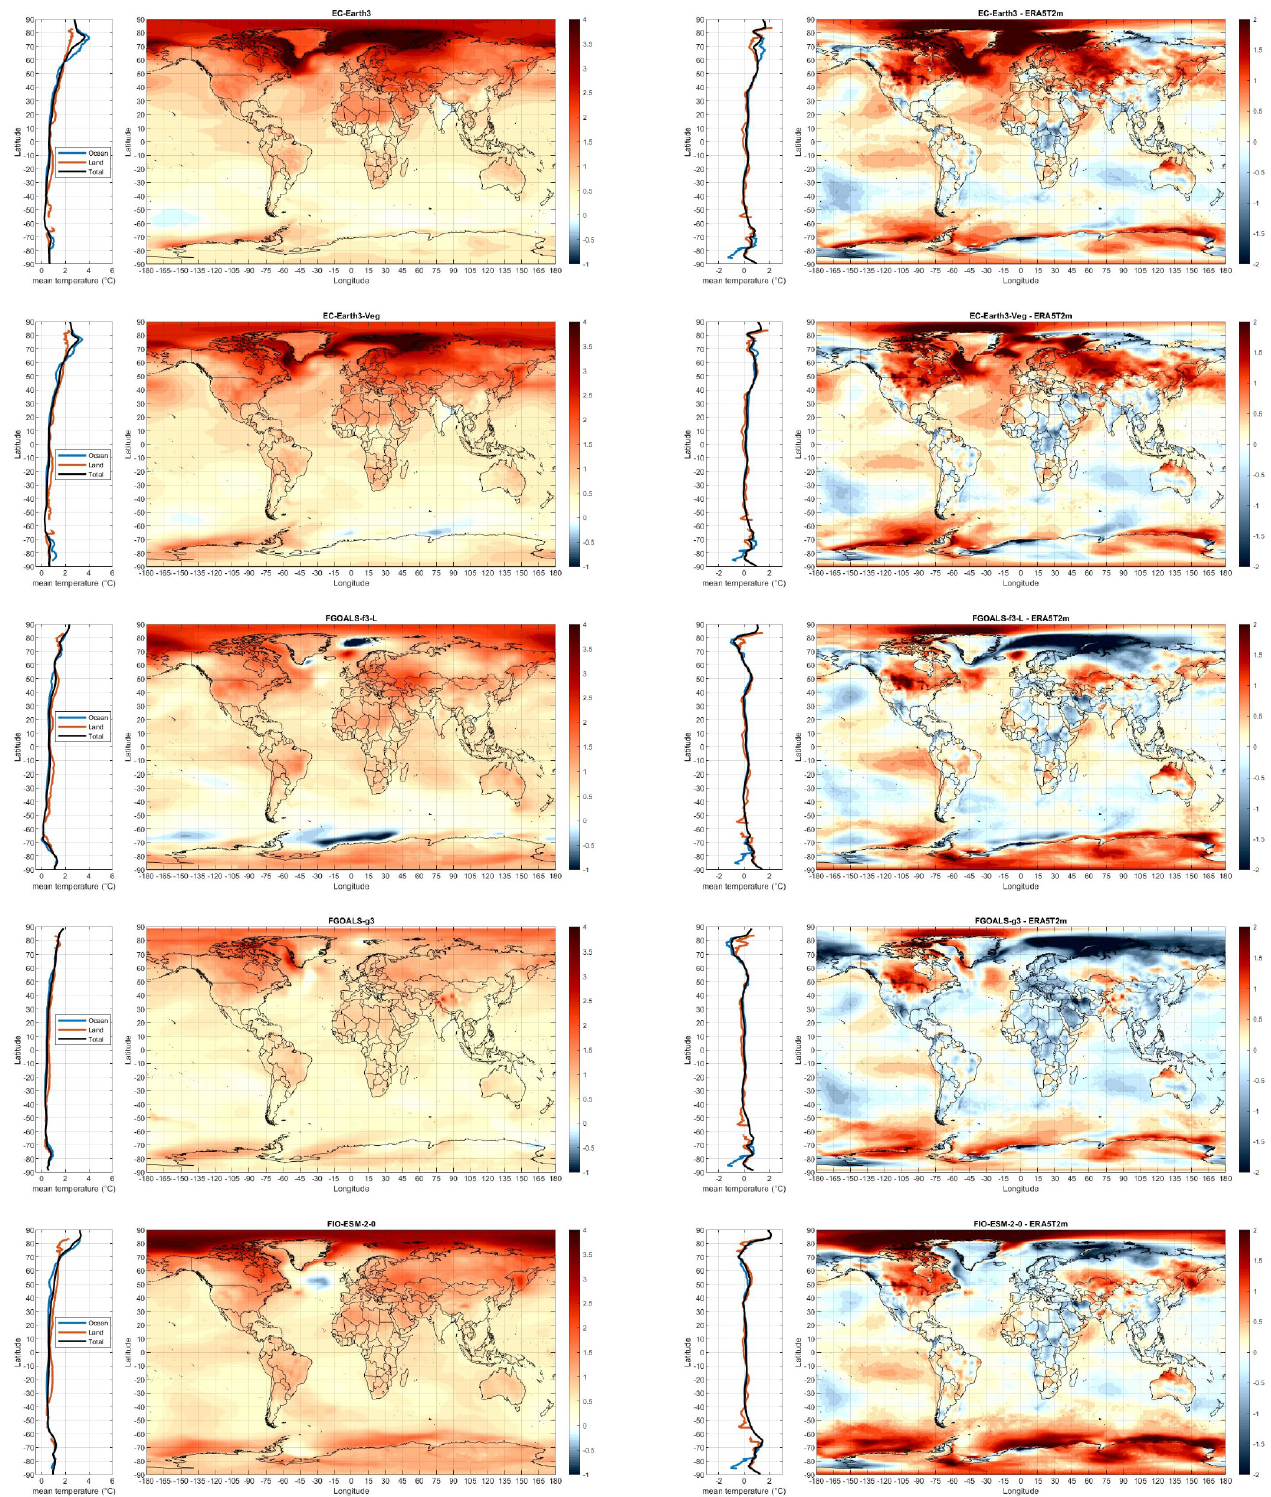
Figure A4. Warming patterns from 1980–1990 to 2011–2021 for the indicated CMIP6-tas GCM ( left ) and its comparison against the ERA5-T2m record ( right